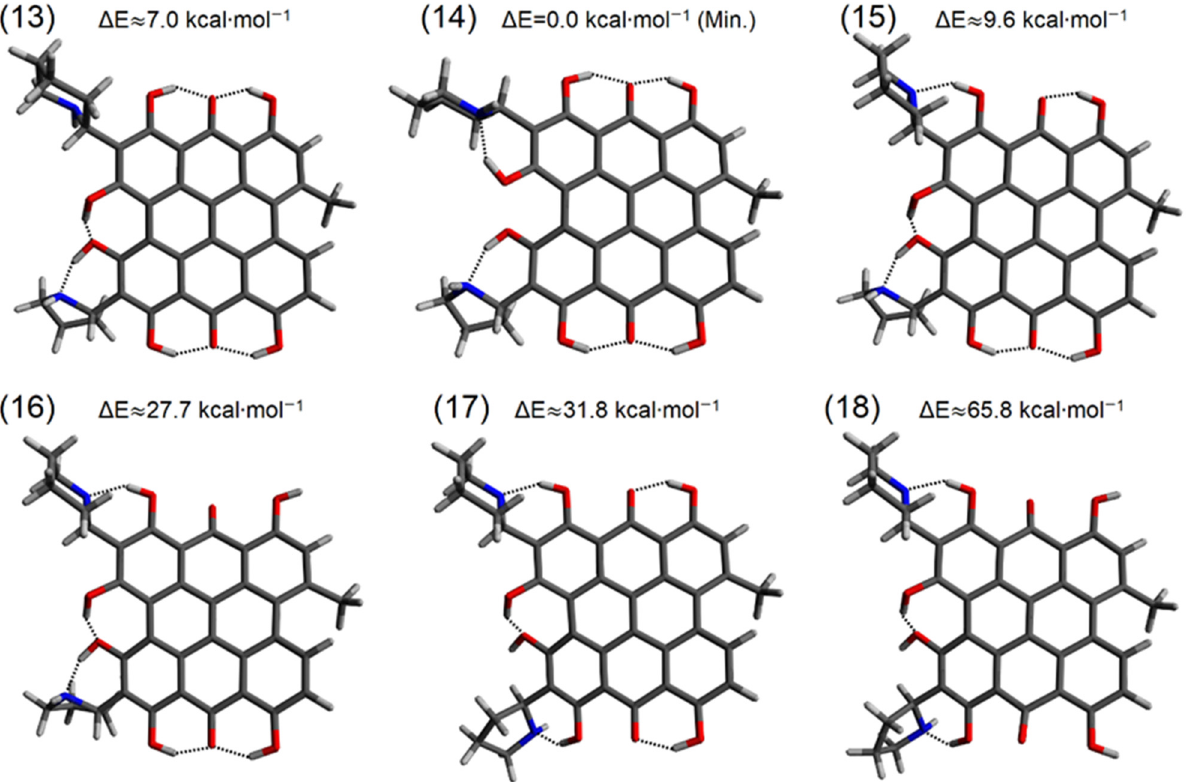
Figure 3. Conformers (13–18) of fagopyrin C.